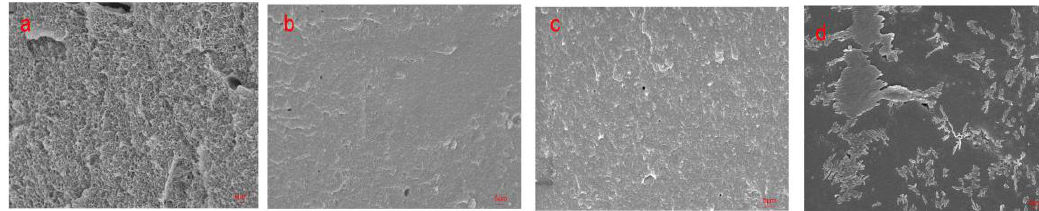
Figure 5. Fracture surface micrographs of the cured adhesive samples: ( a ) SPI adhesive, ( b ) SPI-Urea adhesive, ( c ) SPI-SDS adhesive, ( d ) SPI-SHS adhesive.